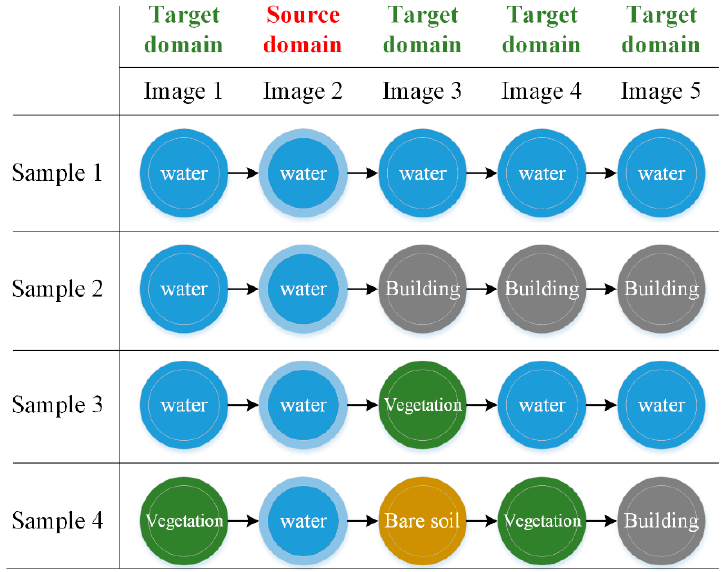
Figure 1. Examples of different types of water time-series samples. Image 2 is the source domain, while the other images are target domains.